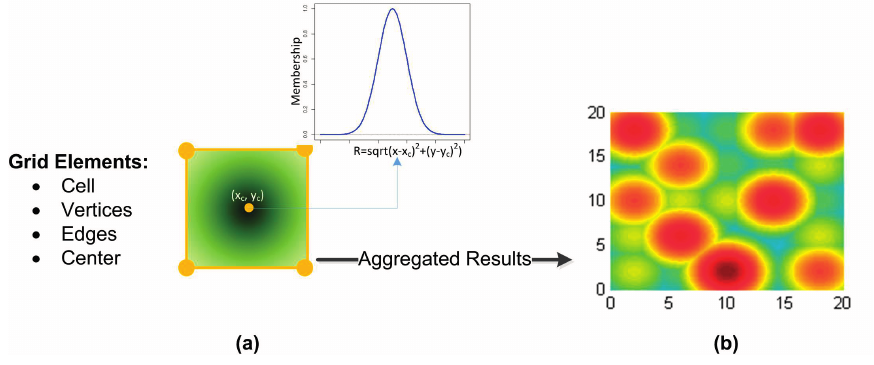
Figure 6. ( a ) Proposed approach based on fuzzy model. ( b ) Fuzzy representation of risk level.